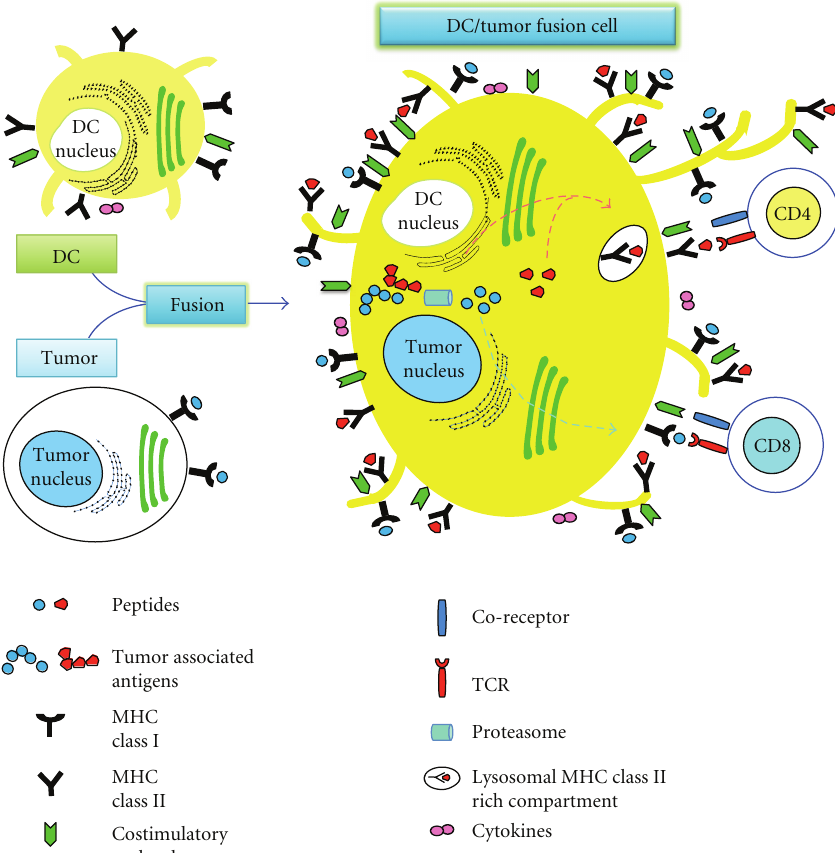
Figure 1: A model of antigen processing and presentation by DC/tumor fusion cell. DC/tumor fusion cell expresses MHC class I, class II, costimulatory molecules, and tumor-associated antigens. Tumor-associated antigens can be processed and presented through the antigen processing and presentation pathway of